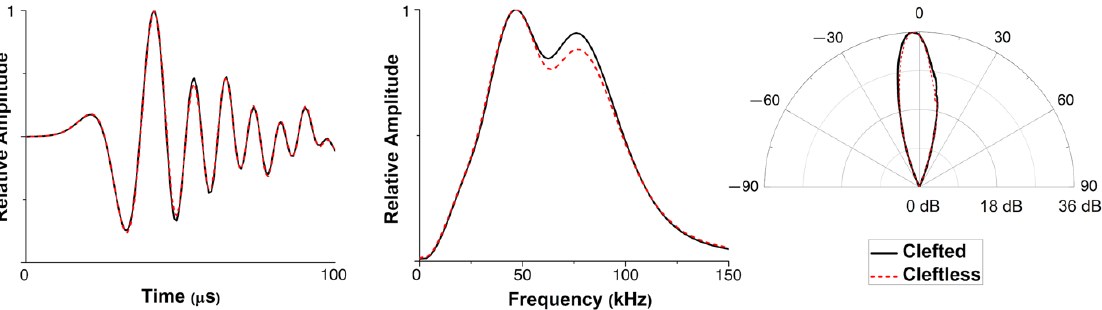
Figure 9. Comparison of the far-field signals, spectra, and beam patterns between the “clefted” case and “cleftless” case in the horizontal FE model.